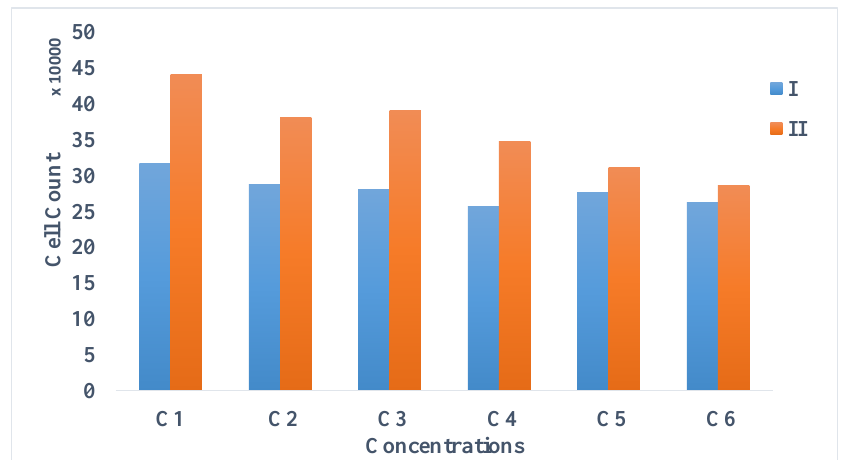
Figure 6. Comparison of TBDE and the cell counter. The trypan blue dye exclusion (I) showing a lower number of cells counted in all the concentrations of SPIONs (C1 = 0, C2 = 25 µg/mL, C3 = 50 µg/mL, C4 = 100 µg/mL, C5 = 200 µg/mL, C6 = 300 µg/mL) compared to the Scepter Handheld Cell counter (II).